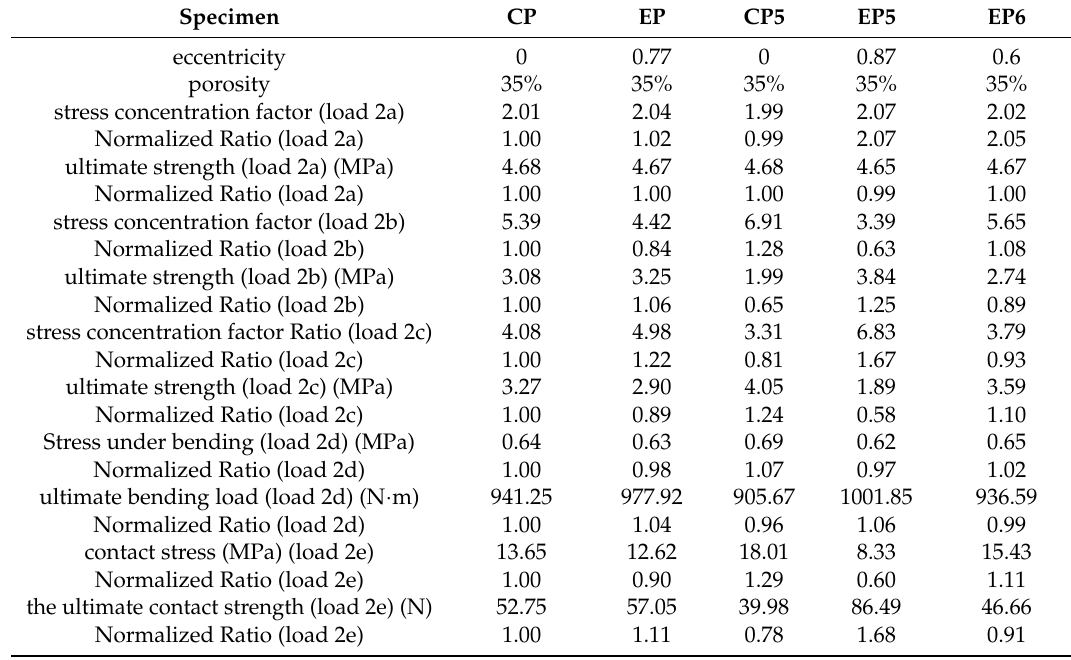
Table 2. Effect of the eccentricity on the mechanical properties.